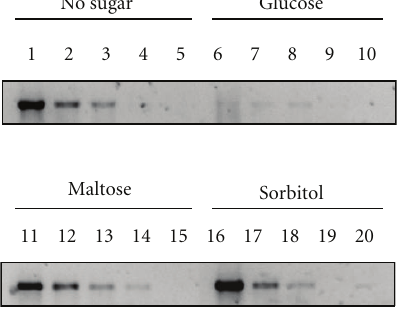
Figure 4: E ff ect of carbon sources on malT con transcription. Semiquantitative RT-PCR of malT con in the ompR malT con double mutant (strain AJW3098) grown under nonpermissive conditions in the absence (lane 1–5) or presence of glucose (lane 6–10), maltose (lane 11–15), or sorbitol (lane 16–20). PCR amplification was carried out with a dilution series of the cDNA: undiluted (lane 1, 6, 11, and 16), 1:10 dilution (lane 2, 7, 12, 17), 1:25 dilution (lane 3, 8, 13, and 18), 1 :125 dilution (lane 4, 9, 14, 19), and mock control (lane 5, 10, 15, and 20).